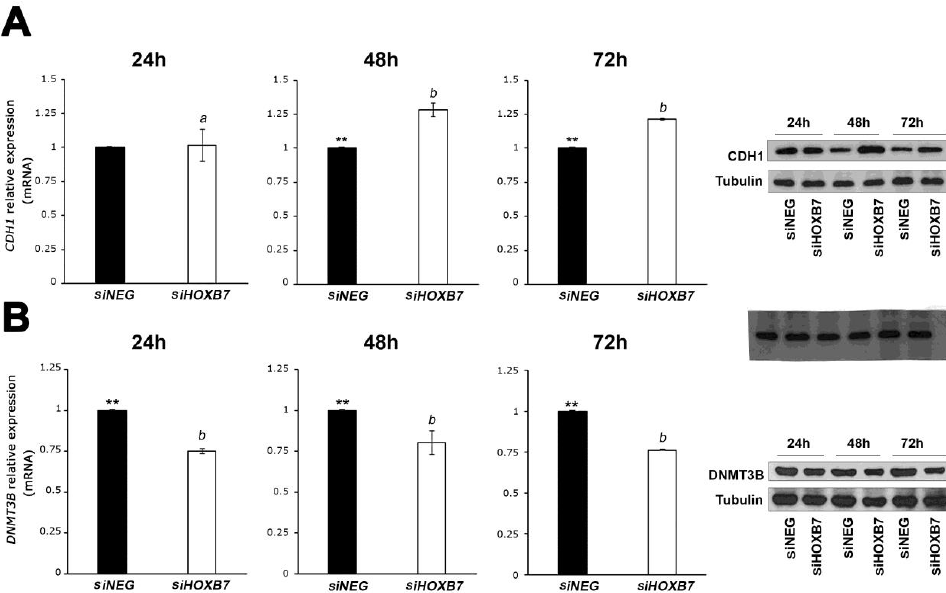
Figure 3. Expression analyses of CDH1 ( A ) and DNMT3B ( B ) in MDA-MB-468 cells transfected with siHOXB7 and siNEG analyzed by RT-qPCR and western blots at three time points post-transfection. Three independent biological replicates were used in the statistical analyses comparing two variants (siNEG and siHOXB7) and the significant differences indicated with asterisks based on the analyses using t -test. The differences in the expression measures at the three time points were compared using the post hoc Tukey test. CDH1 expression was significantly higher in siHOXB7-transfected cells than in controls at 48 h and 72 h (**, p < 0.05). Comparing the three time points, the expression of CDH1 is significantly different at 24 h in these cells ( a ) in comparison with 48 h and 72 h. No significant differences in CDH1 expression were detected between 48 h and 72 h ( b ). DNMT3B expression was significantly lower in HOXB7-silenced cells than in the controls in the three time points analyzed, and no significant differences were detected in the expression between these time points ( b ). In the western-blot analyses, β -tubulin was used as the reference protein. a : significant expression differences between time-points in the siHOXB7 cells evaluated with post hoc Tukey test; b : no significant expression differences between time-points in the siHOXB7 cells evaluated with post hoc Tukey